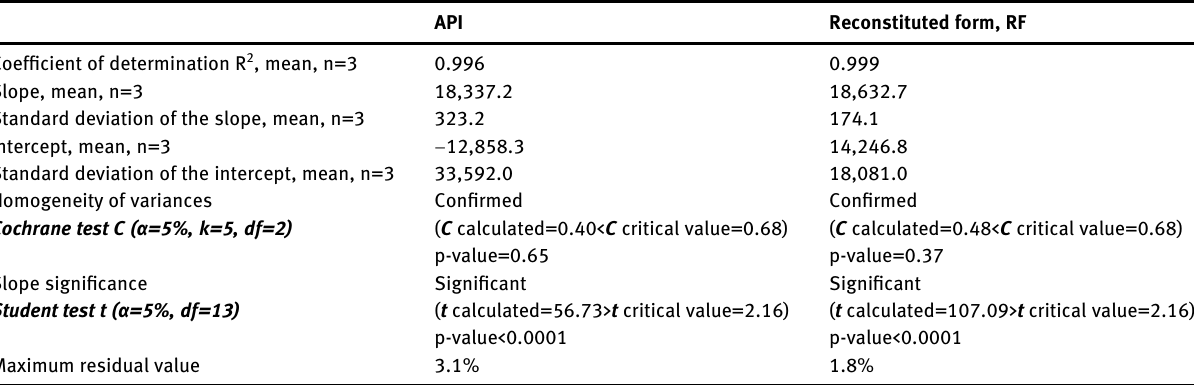
Table  : Linearity data of HPLC-UV method.